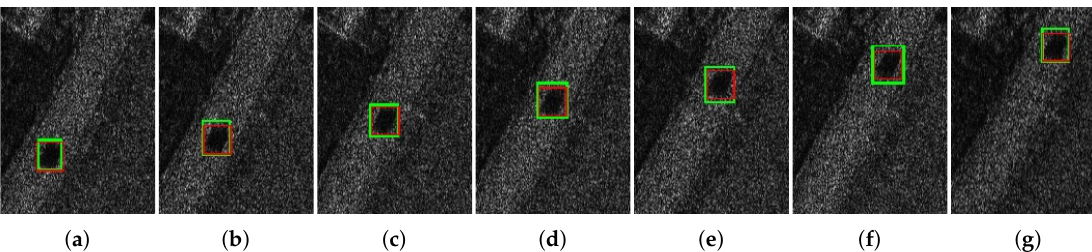
Figure 16. Partial tracking results of SiamFc of simulated video-SAR data. Green rectangles are the true trajectory of target, and red rectangles represent tracking results. ( a – g ) are the corresponding results of frame 1, 10, 20, 30, 40, 50 and 60, respectively.